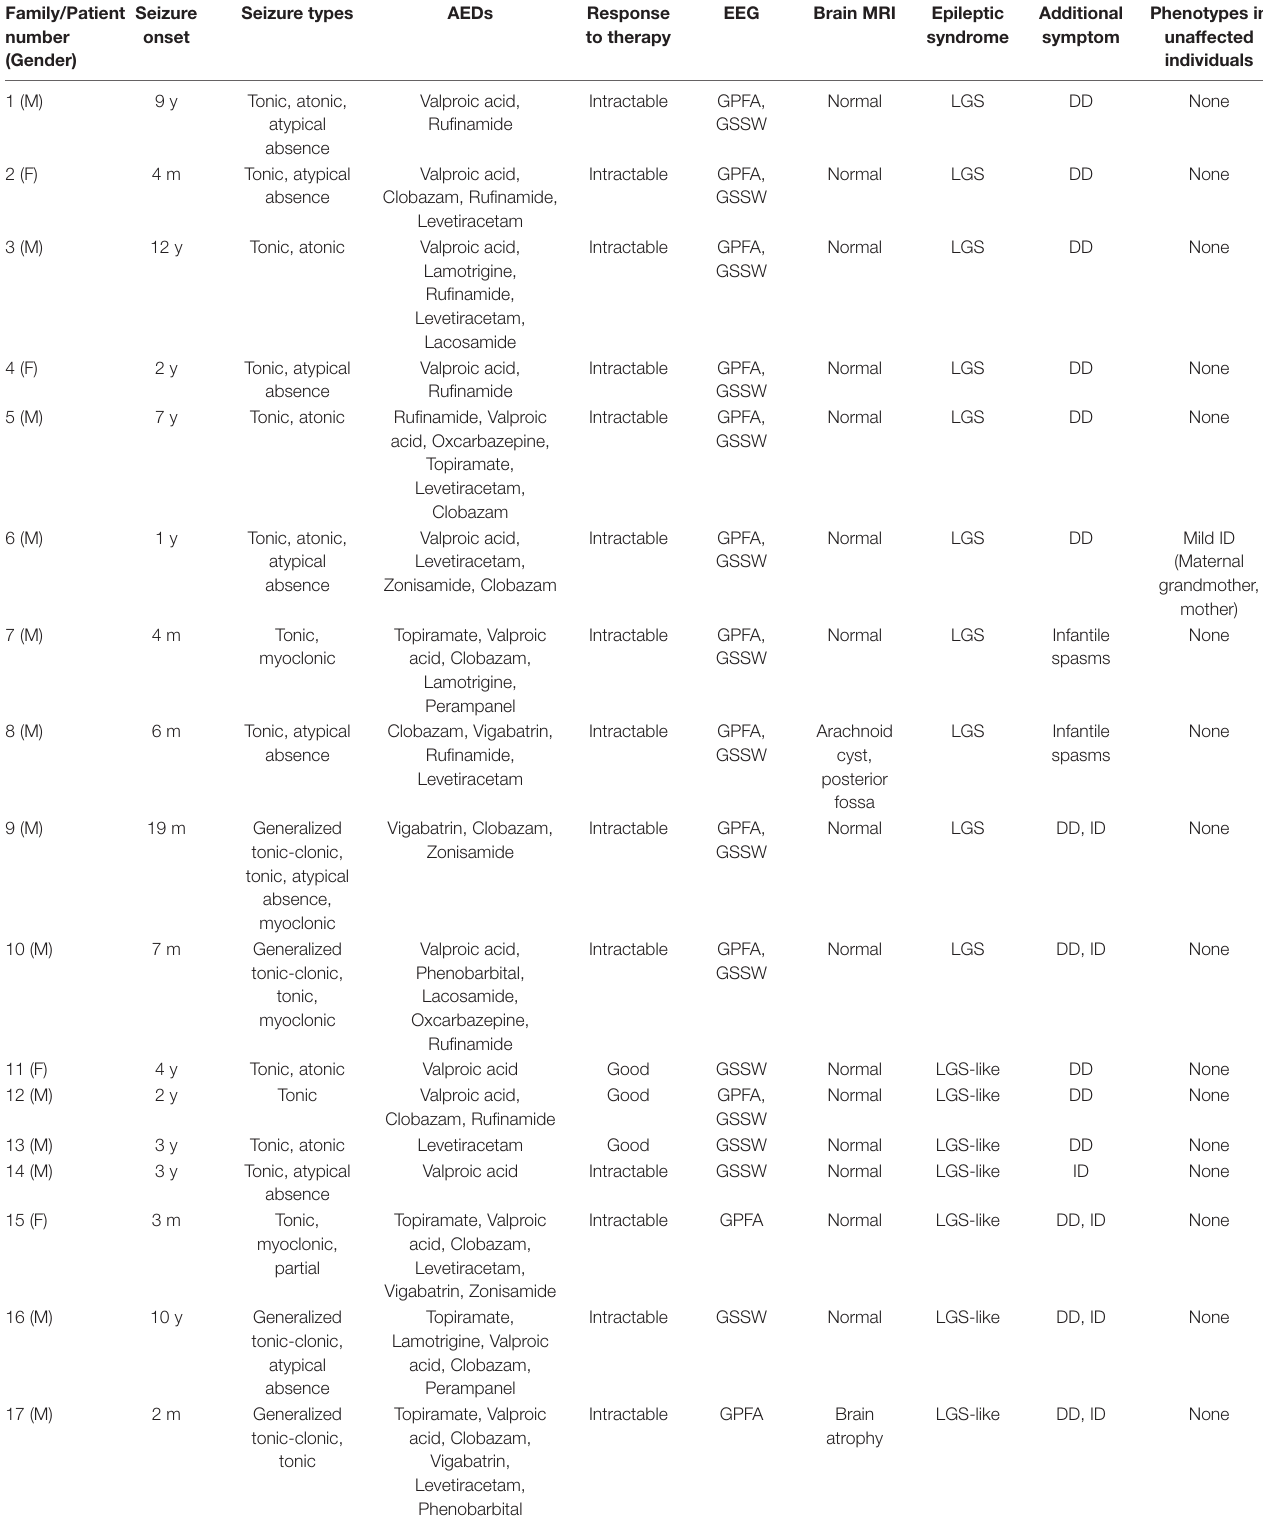
TABLE 1 | Clinical features of patients with LGS and LGS-like epilepsy. Family/Patient Seizure number (Gender)